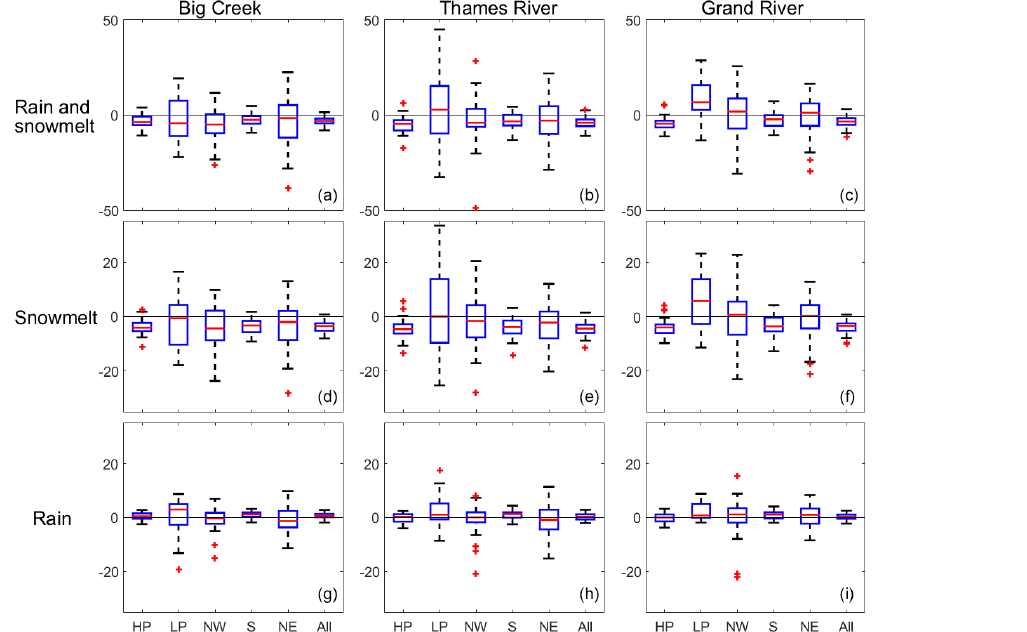
Figure 10. Distribution of simulated change in rain and snowmelt amounts (mm water equivalent) for all compound extreme events be- tween 1961–1990 and 2026–2055 from the 50 members of the